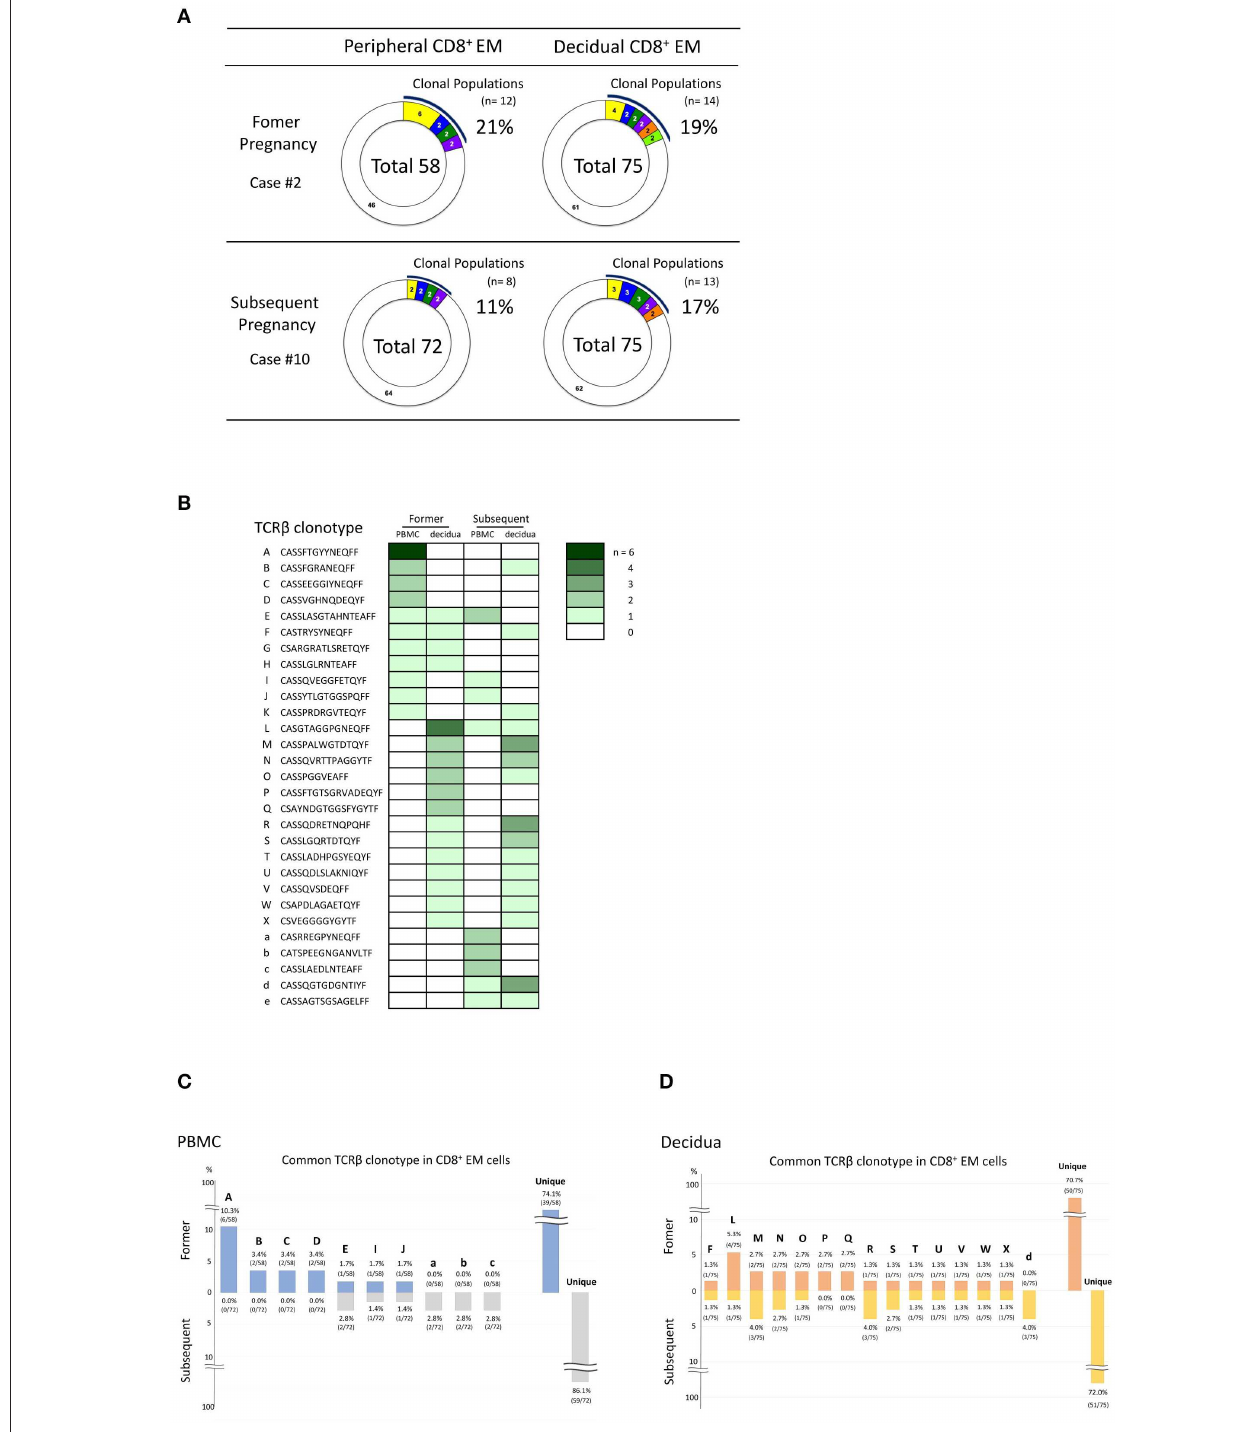
FIGURE 4 | Comparison of the TCR β clonotype during normal early pregnancy in consecutive pregnancies of the same subject (case numbers #2 and #10, obtained from the same patient). (A) Analysis of the TCR β repertoire in pCD8 + EM and dCD8 + EM cells in different pregnancies of the same series. (B) TCR β clonotype comparison in different pregnancies of the same series. TCR β clonotypes of clonally expanded CD8 + EM cells in PBMC or decidua and/or TCR β clonotypes in common between pCD8 + EM and dCD8 + EM cells are shown in a row (A to W, a to e) (the color density indicates the number of clones). Comparison of CD8 + EM TCR β clonotype between two different pregnancies in PBMC (C) and the decidua (D) . The number above or under each bar is the percentage of CD8 + EM cells with a particular TCR clone among total CD8 + EM cells with an identified TCR β repertoire.